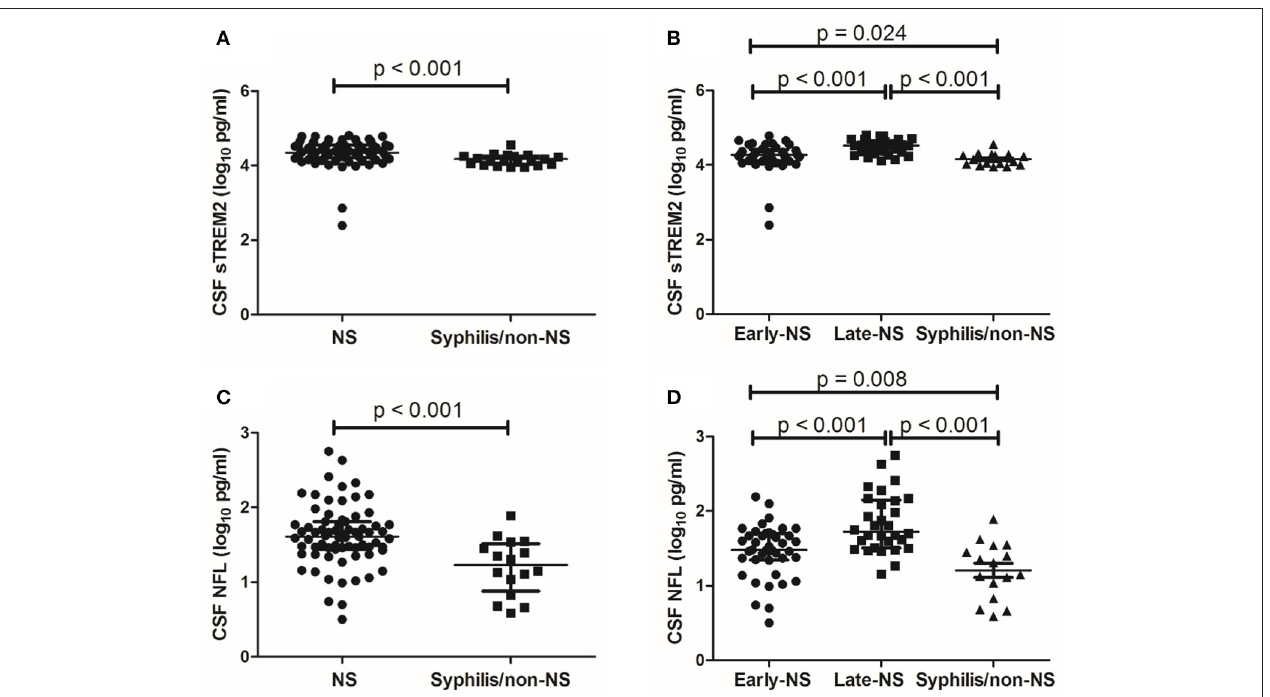
FIGURE 1 | CSF levels of sTREM2 and NFL in NS and syphilis/non-NS patients. (A) Patients with NS had significantly higher levels of CSF sTREM2 (log 10 pg/ml) than those with syphilis/non-NS. (B) The CSF sTREM2 (log 10 pg/ml) levels in late-NS were significantly higher than in early-NS and syphilis/non-NS. The CSF sTREM2 (log 10 pg/ml) levels in early-NS were also significantly higher than in syphilis/non-NS. (C) Patients with NS had significantly higher levels of CSF NFL (log 10 pg/ml) than those with syphilis/non-NS. (D) The CSF NFL (log 10 pg/ml) levels in late-NS were significantly higher than in early-NS and syphilis/non-NS. The CSF NFL (log 10 pg/ml) levels in early-NS were also significantly higher than in syphilis/non-NS. NS, neurosyphilis; sTREM2, soluble triggering receptor expressed on myeloid cells 2; NFL, neurofilament light protein.